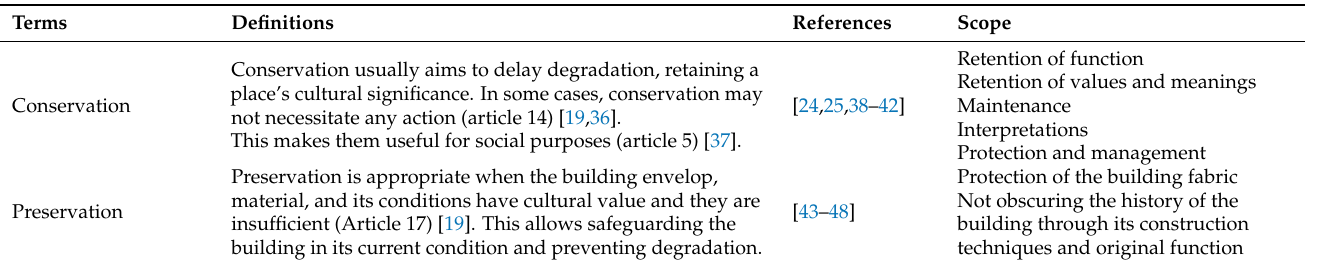
Table 1. Summary of literature reviews for the heritage building adaptation process and its